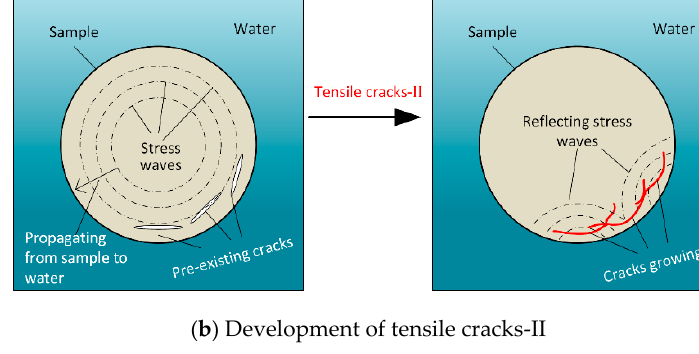
Figure 11. Schematic for the formation mechanism of tensile cracks-I and -II.